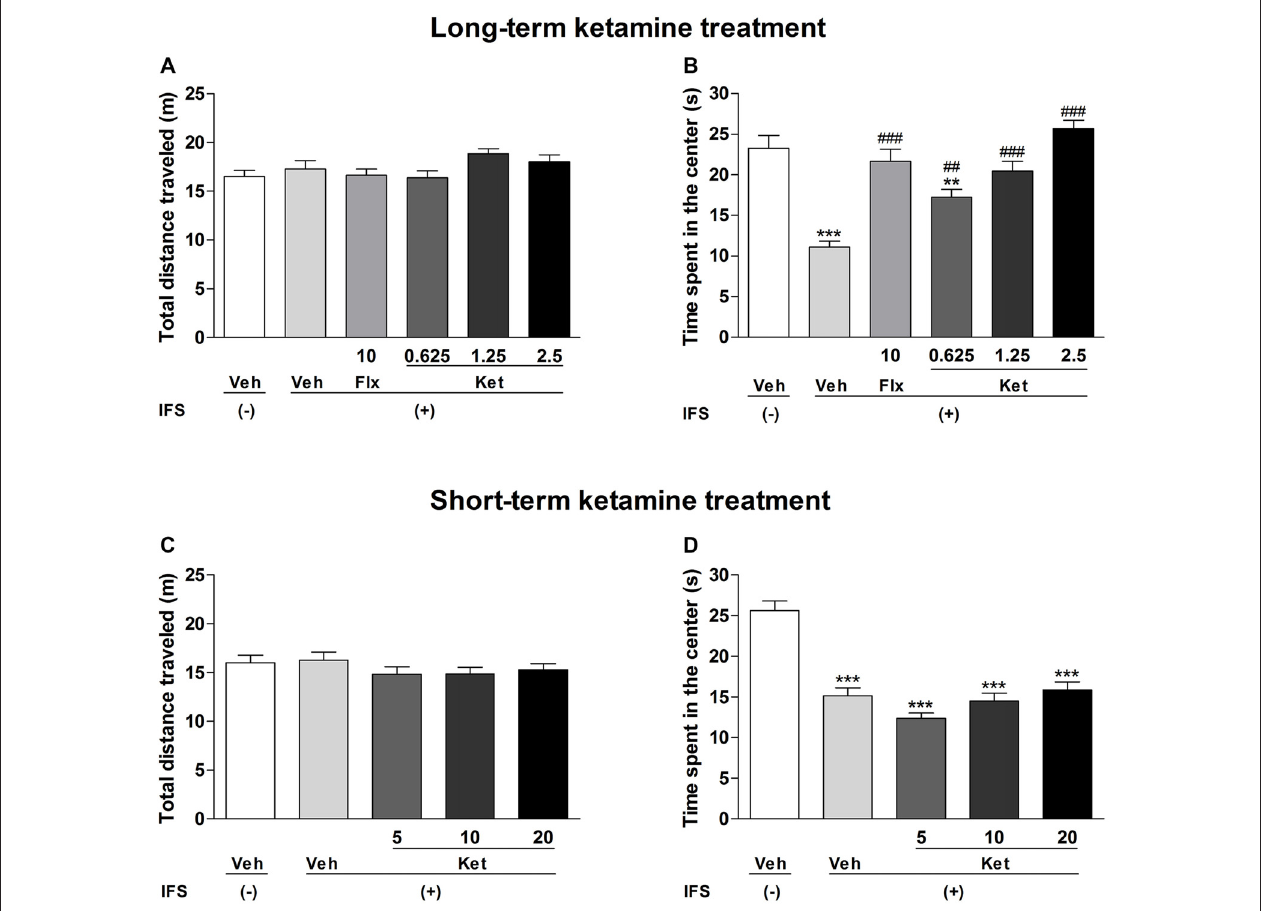
FIGURE 3 | The effects of ketamine on OF test in IFS mice. (A) No significant difference was observed among the groups in the total distance traveled. (B) The IFS mice spent a significant shorter time in the center, which was significantly ameliorated in the groups that were administered either Flx or long-term ketamine treatment. (C,D) IFS mice manifested the normal locomotor activity, accompanying the shorter time spent in the center in the OF test, while short-term ketamine treatment didn’t alleviate the abnormalities. Data are presented as mean ± SEM ( n = 15 in per group). ∗∗ P < 0.01, ∗∗∗ P < 0.001 compared with the Veh group; ## P < 0.01, ### P < 0.001 compared with the IFS + Veh group.